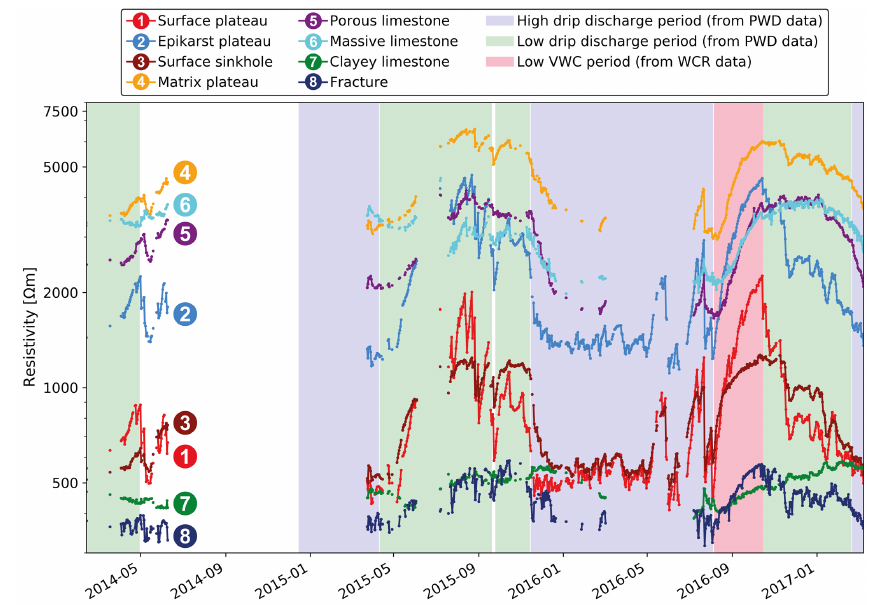
Figure 11. Resistivity time series for the eight regions detailed in Fig. 7, expressed as the median of the log resistivity in each region. The median was chosen, rather than the mean, to limit the contribution of extreme values not representative of the robust central tendency of the cells of each region, especially at their boundaries. The dry and wet periods described in Fig. 3 are also